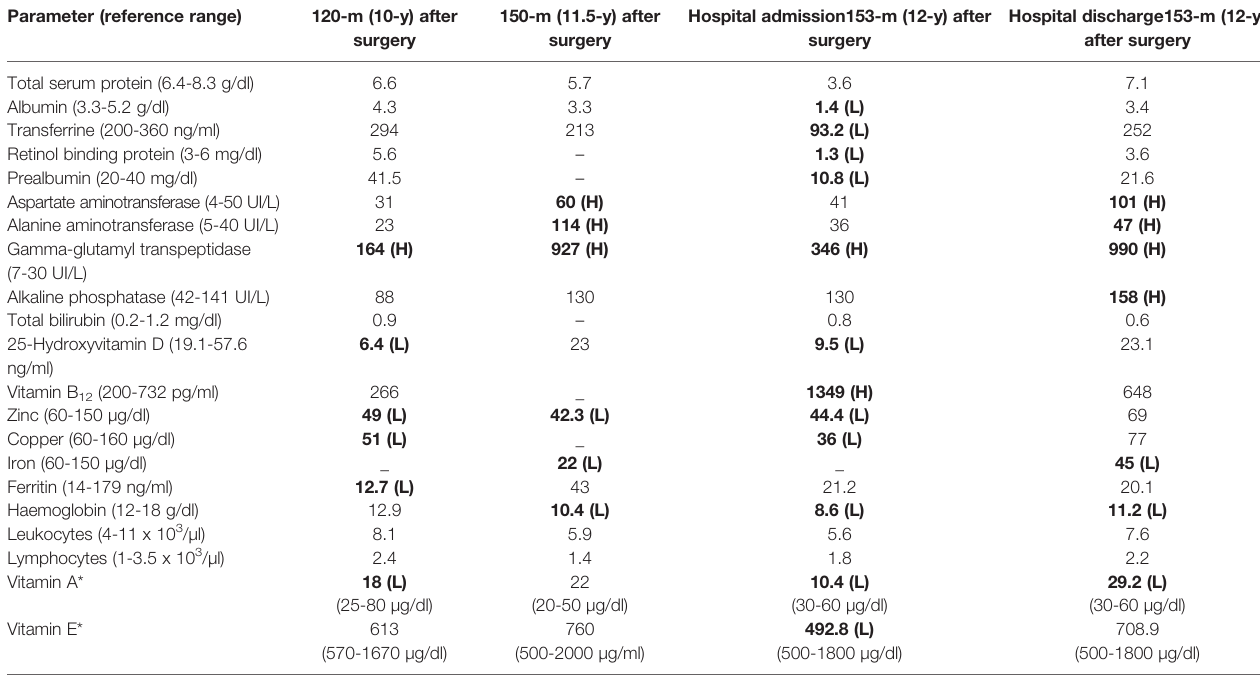
TABLE 2 | Serum laboratory results during hospital admission and follow up. Parameter (reference